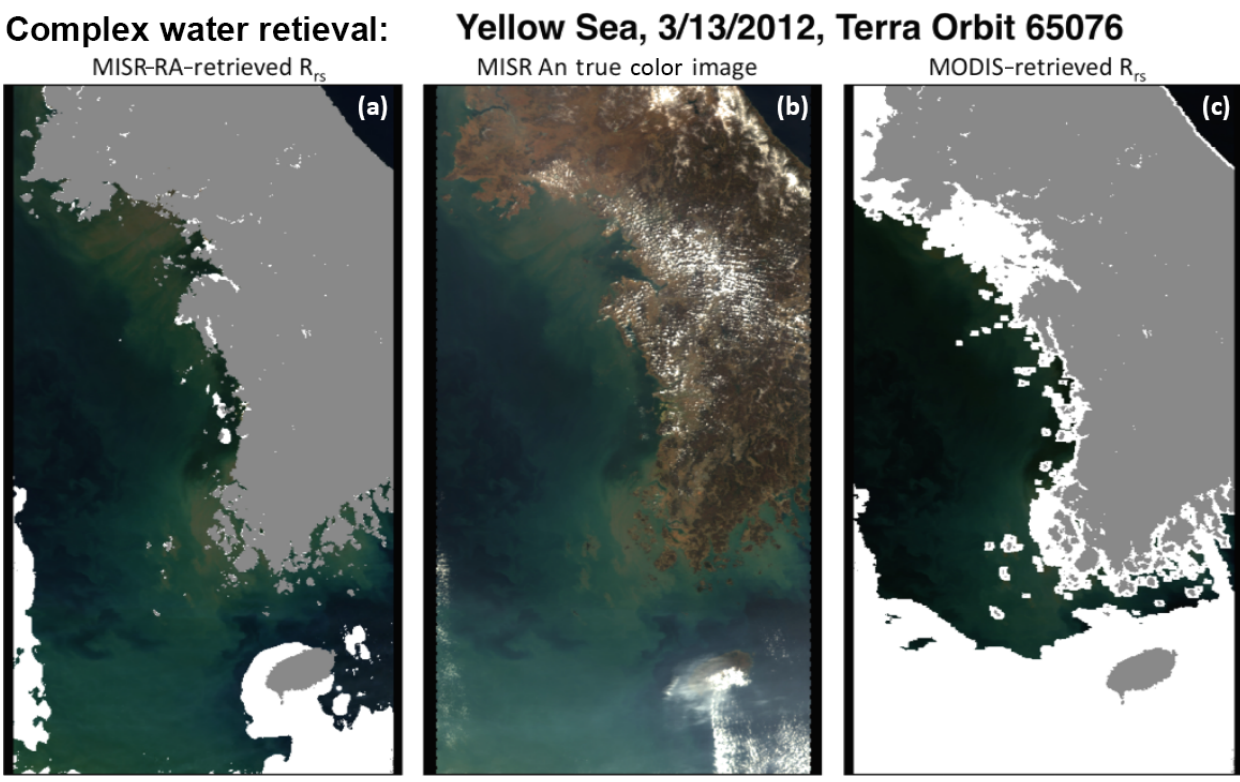
Figure 5. MISR (and MODIS) retrieval imagery acquired on 13 March 2012, 02:30Z: Terra Orbit 65076, blocks 60–64. RGB images have been brightness-enhanced. Panel (b) represents the MISR An true-color Rayleigh-corrected RGB for the scene. Panel (a) represents the MISR-RA-retrieved R rs RGB image, and panel (c) represents the MODIS-retrieved R rs RGB